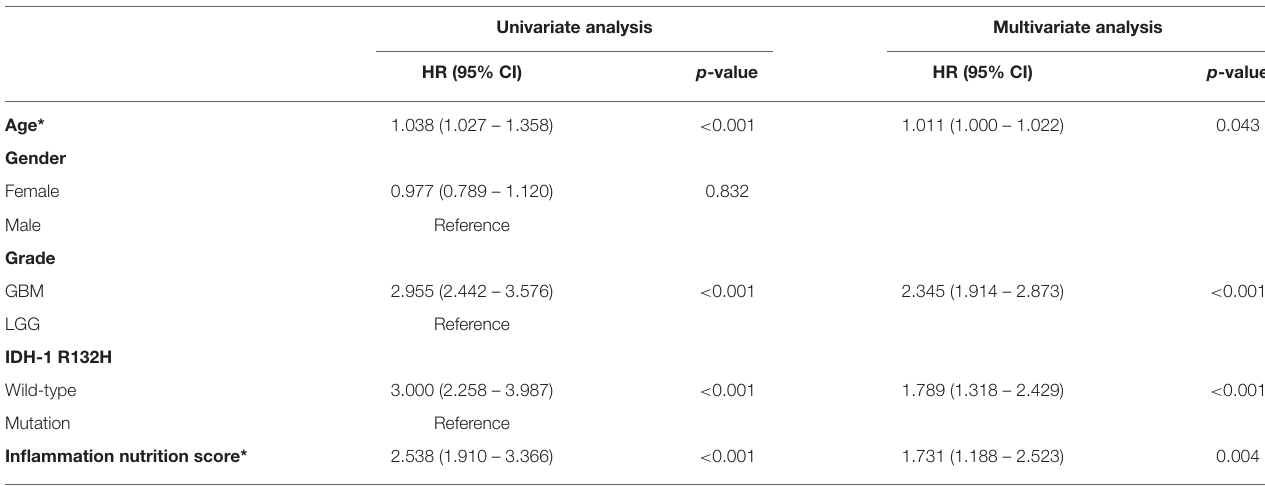
TABLE 2 | Univariate and multivariate cow analysis of primary